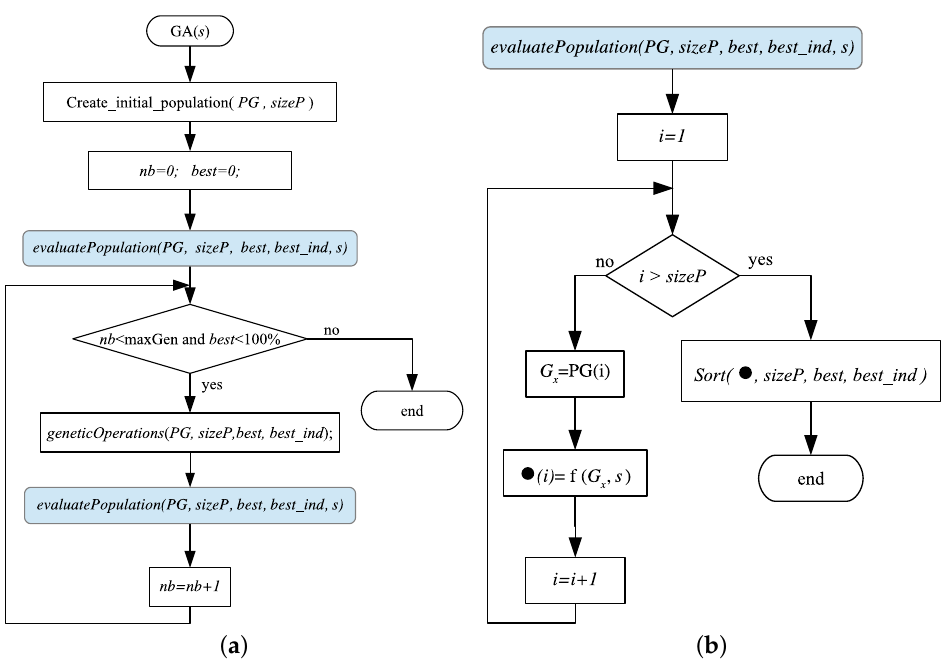
Figure 11. Flowchart showing the general GA algorithm implementation. ( a ) Implementation of the proposed General flowchart GA, and ( b ) GA implementation for a particular s-scenery.